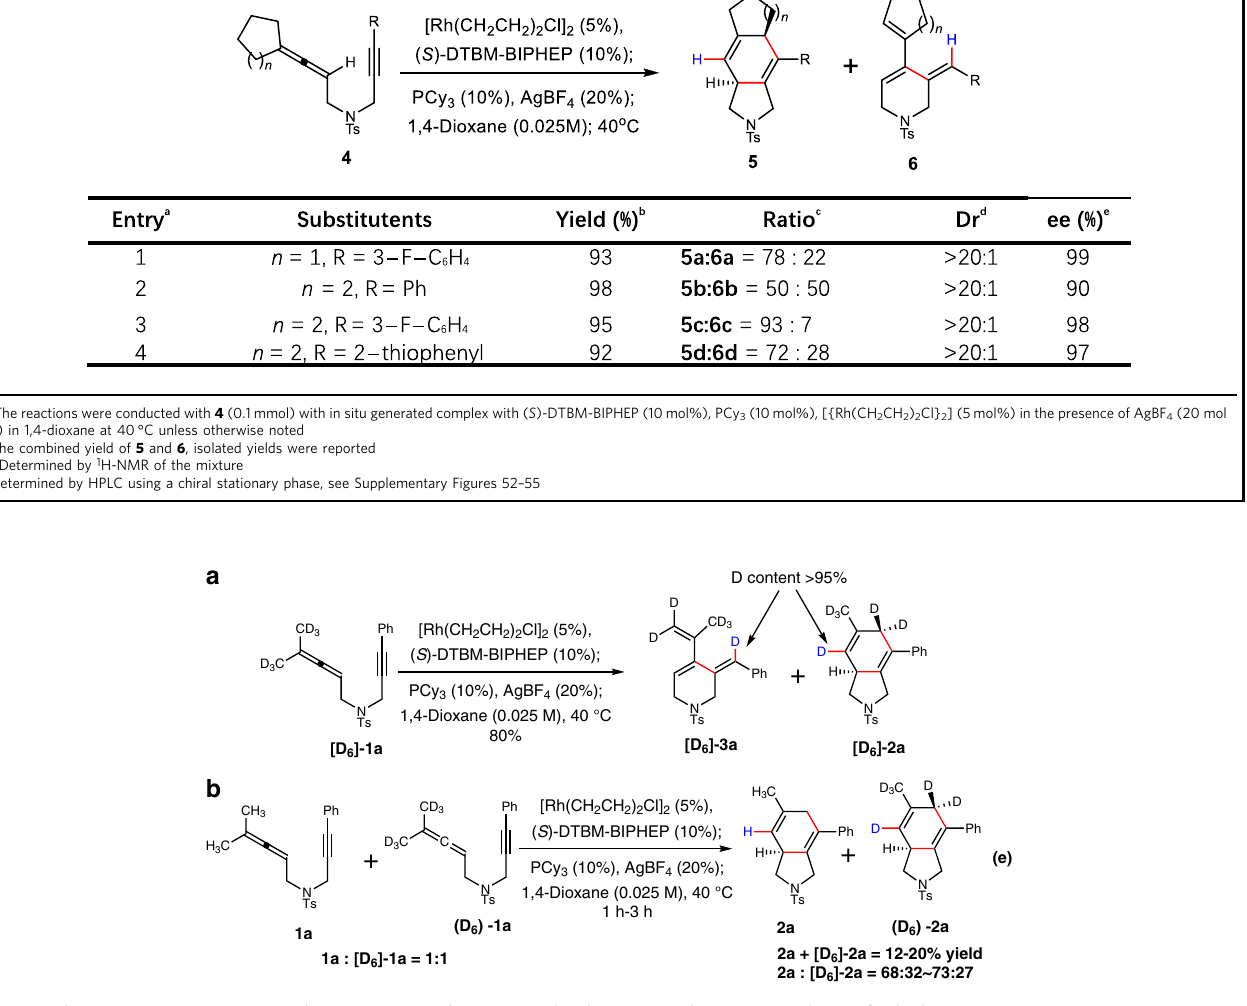
Fig. 2 Mechanistic investigations. a Cycloisomerization of [D 6 ]- 1a under the optimized reaction conditions; b The kinetic isotope competition experiment by using the mixture of 1a and [D 6 ]-